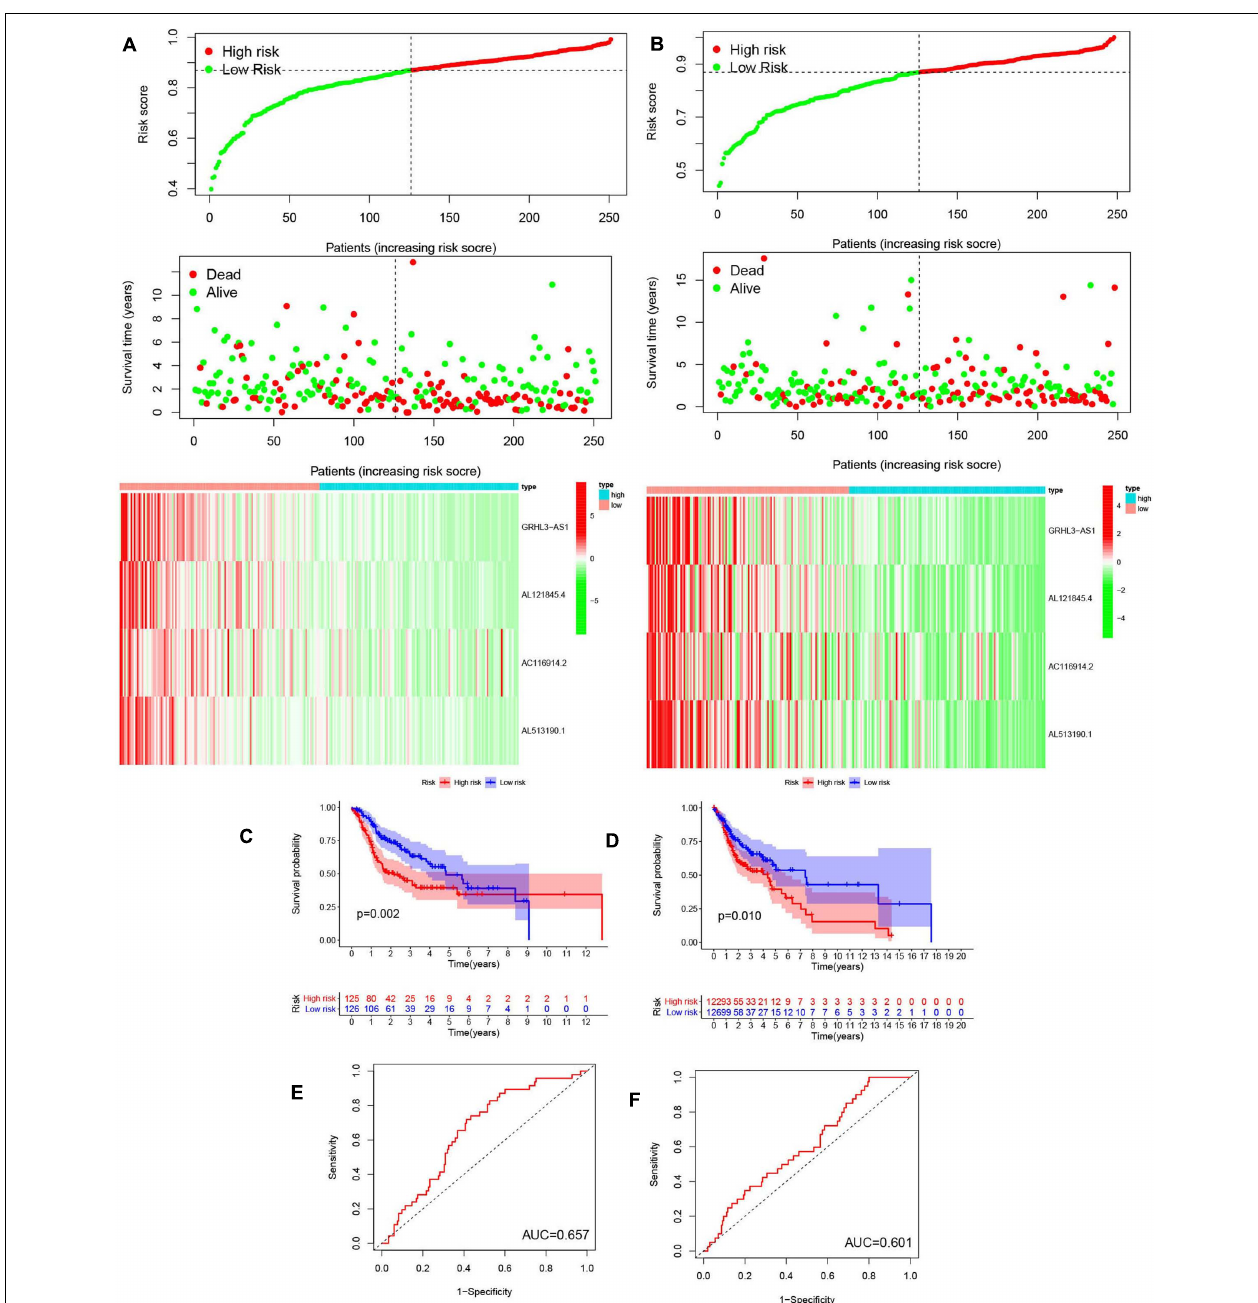
FIGURE 8 | Construction and validation of prognostic signatures of m 6 A methylation regulators. (A,B) Distribution of risk score, OS, and OS status and heatmap of the four prognostic signatures in the train cohort (A) and test cohort (B) . (C,D) Kaplan-Meier curves of OS for patients with HNSCC based on the risk score in the train cohort (C) and test cohort (D) . (E,F) ROC curves measuring the predictive value of the risk score in the train cohort (E) and test cohort (F) .